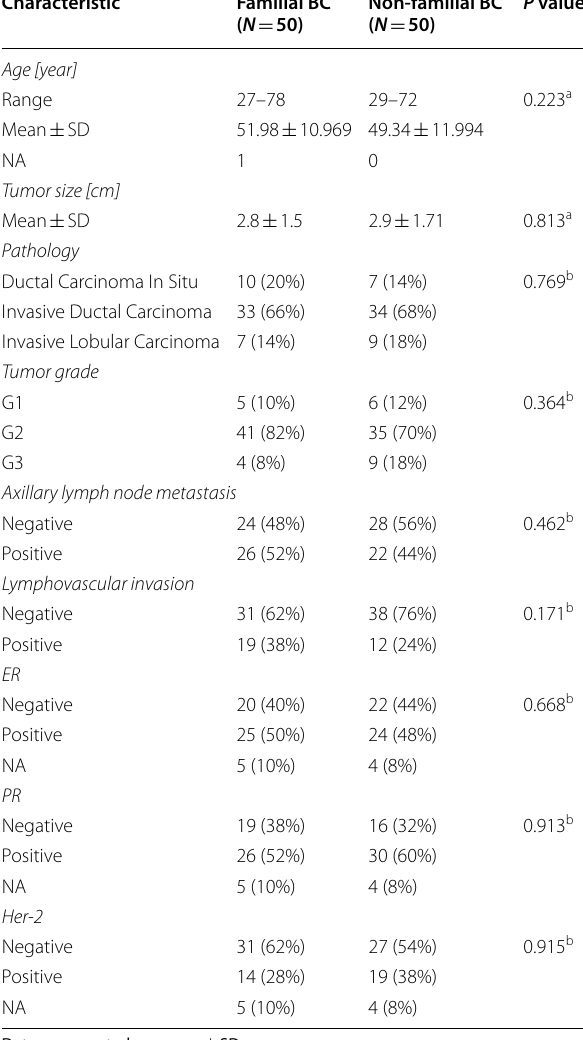
Table 2 Clinical and pathological characterization of familial versus non-familial BC